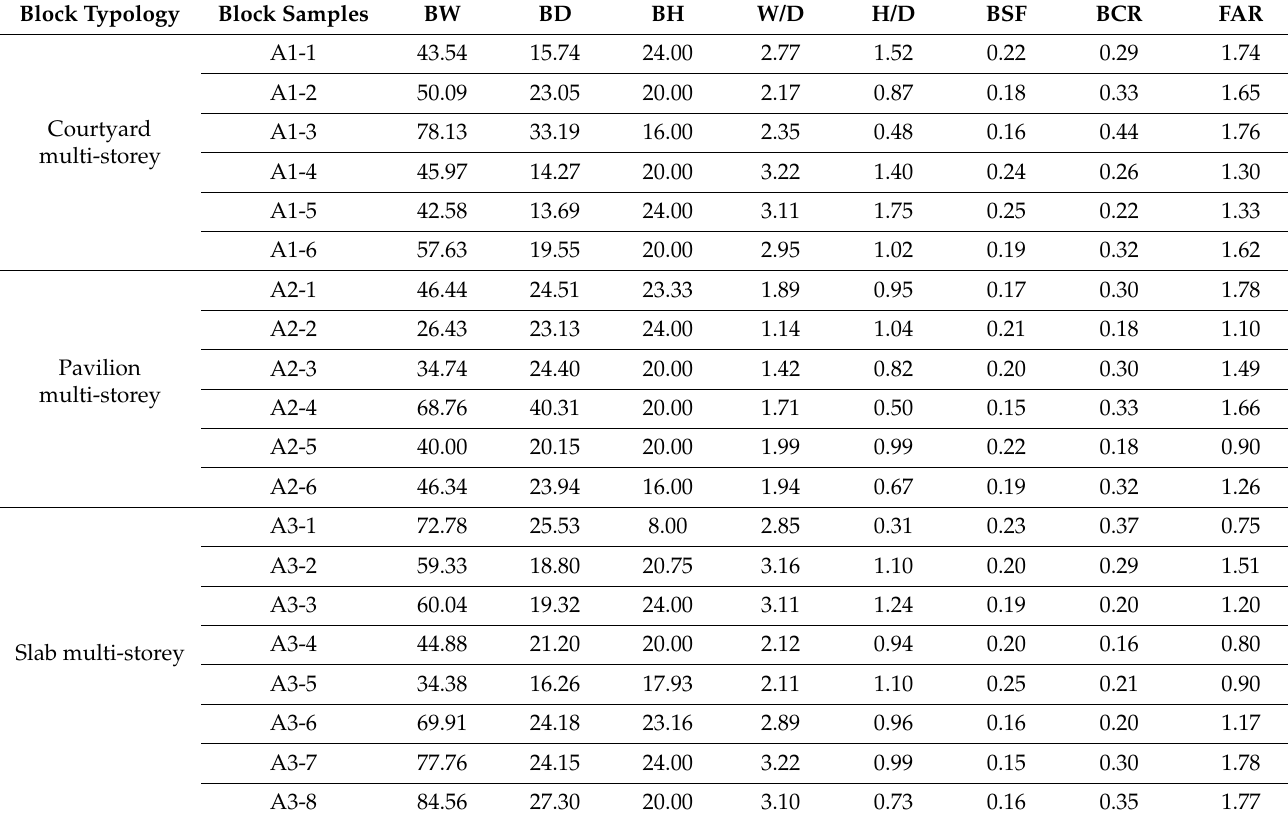
Table A1. Block morphological parameters of 60 block